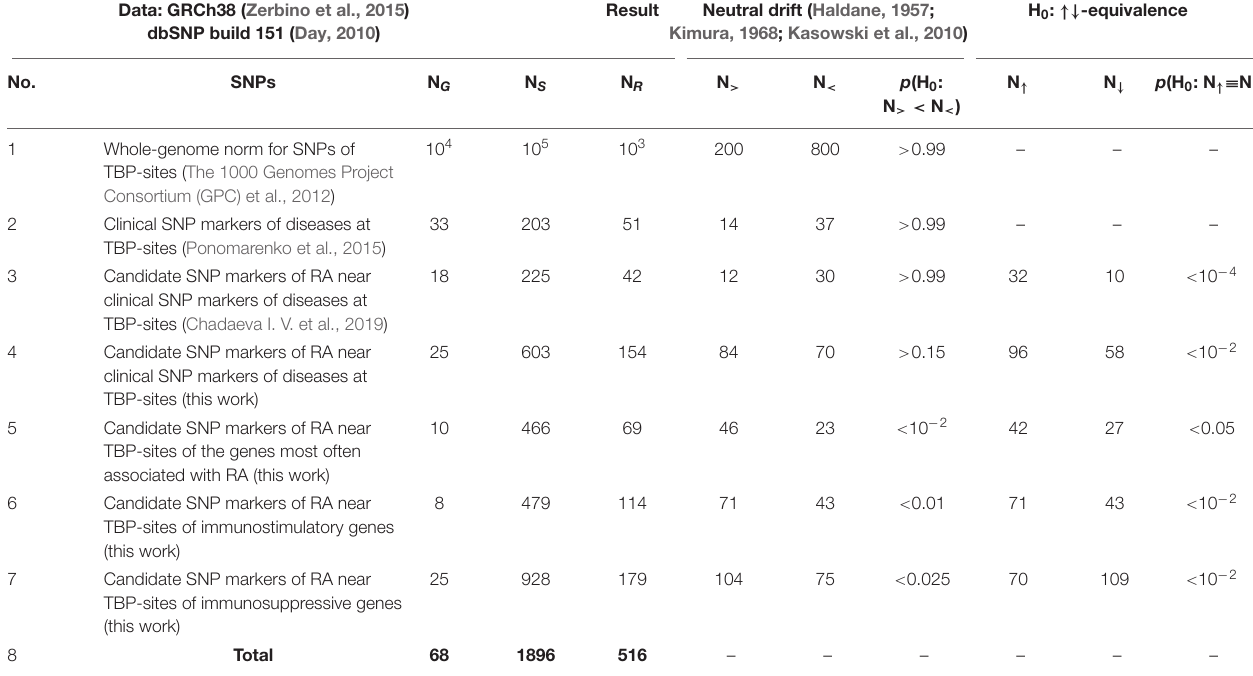
TABLE 2 | Candidate SNP markers of rheumatoid arthritis (RA) that are located near TBP-sites of human gene promoters as predicted in this work, in comparison with genome-wide